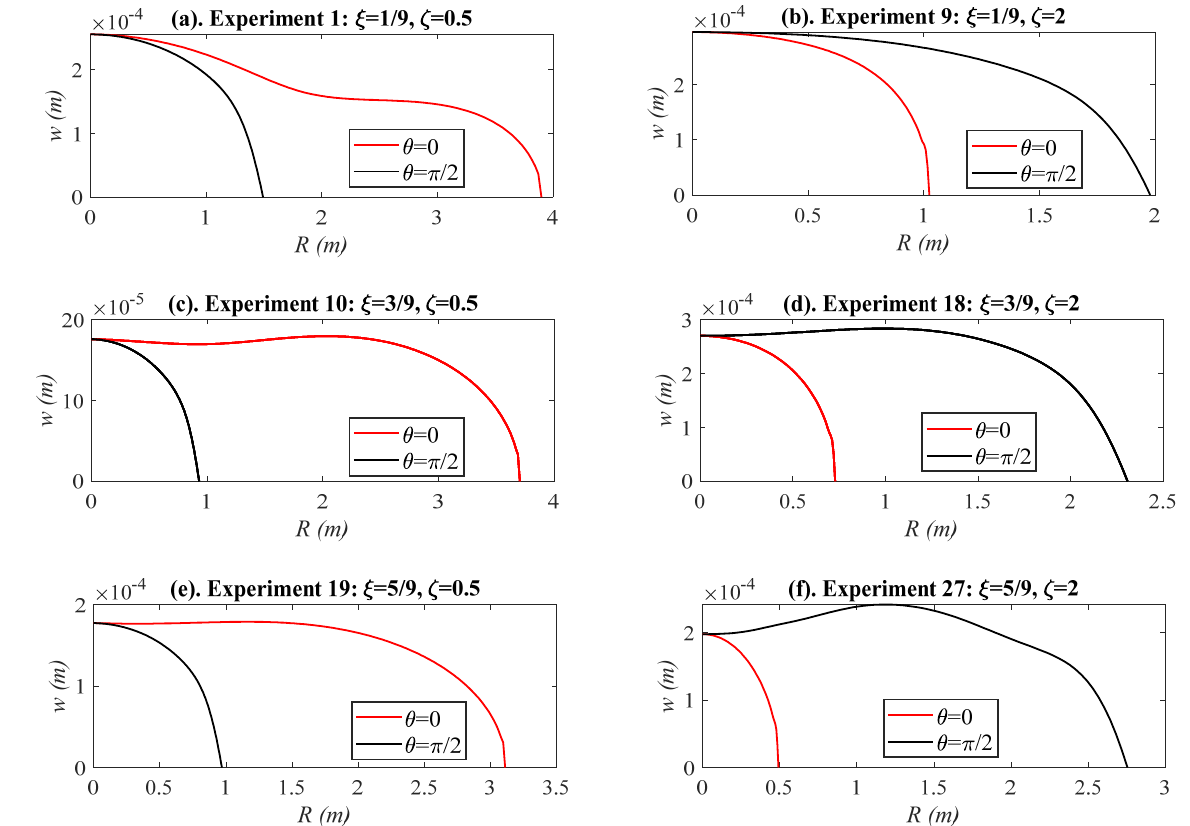
Figure 13. Comparison of fracture openings along radial zones θ = 0 and θ = π /2 of experiments 1, 9, 10, 18, 19, 27.